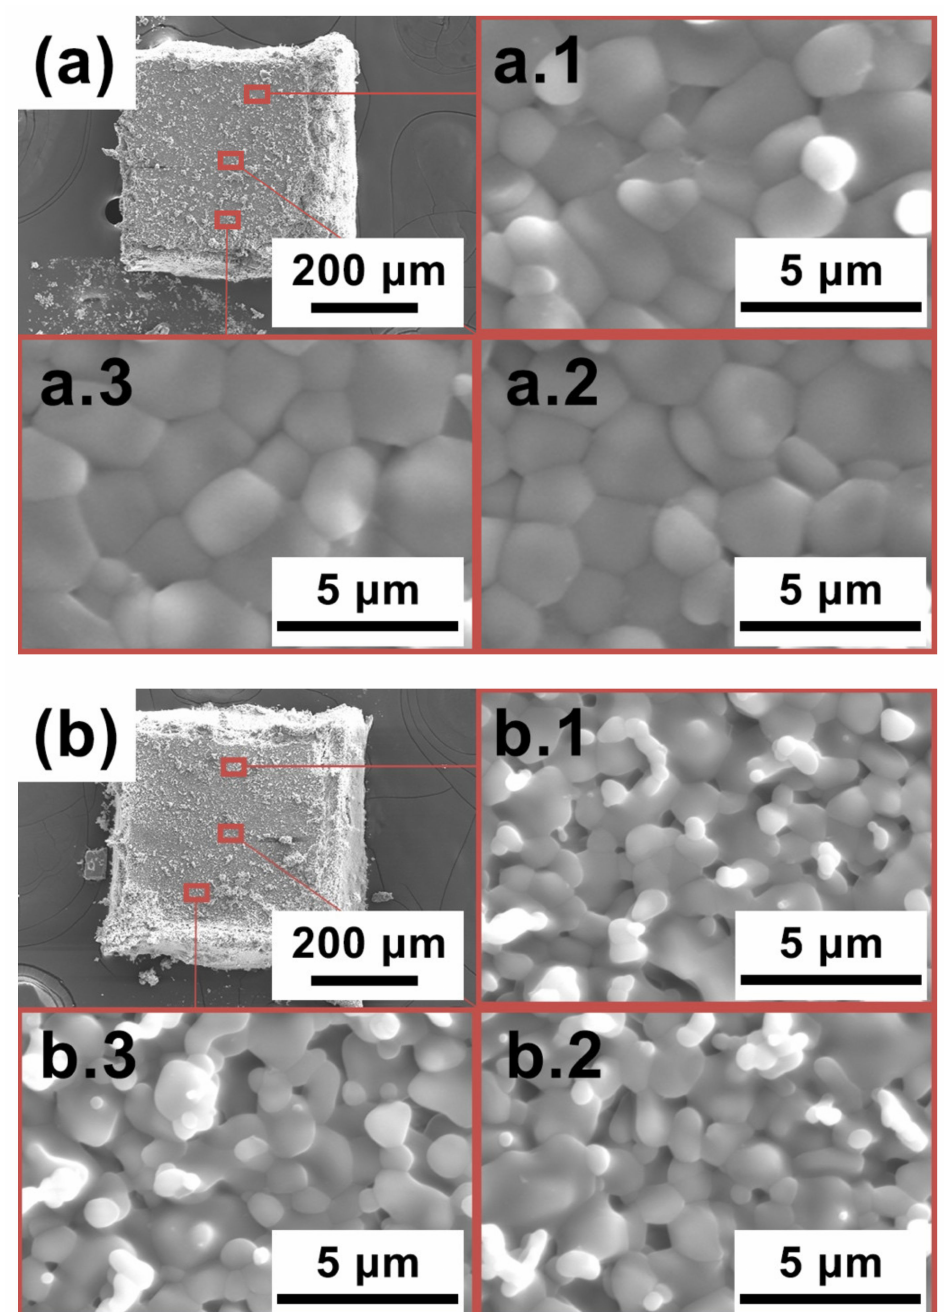
Figure 4. Laser-fabricated alumina sample units from the same arrays. These sample units had different microstructures: ( a ): high relative density unit. ( a.1 – 3 ) are high-magnification images from different marked locations. These micrographs show a uniform microstructure within one sample unit. ( b ): lower relative density unit. ( b.1 – 3 ) are high-magnification images from different marked locations within one unit and show a uniform microstructure in one sample